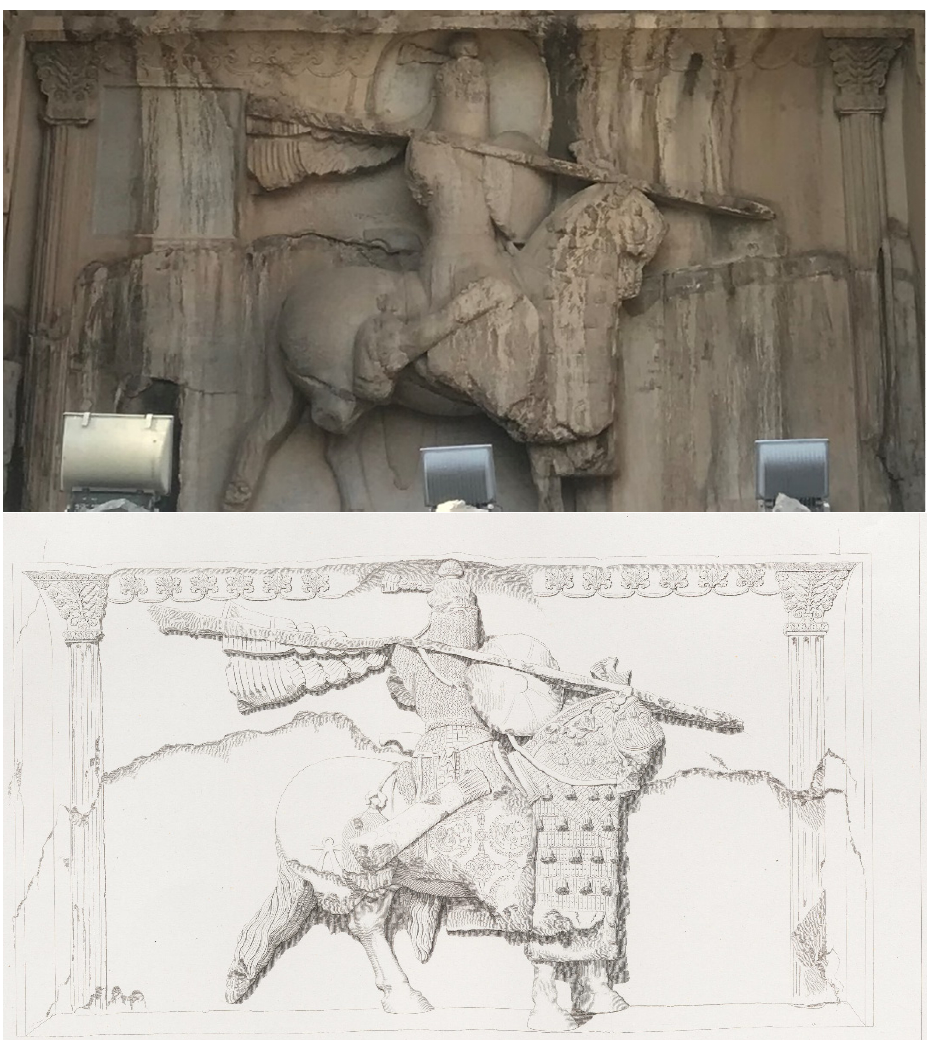
Figure 3. The armored warrior, rock relief, end of the 6th century CE, Taq-e Bustan, The Great Grotto. Photographed by authors, the drawing is taken from: Flandin, E.; Coste, P. Voyage en Perse, Gide et J. Baudry, Paris, France 1851.